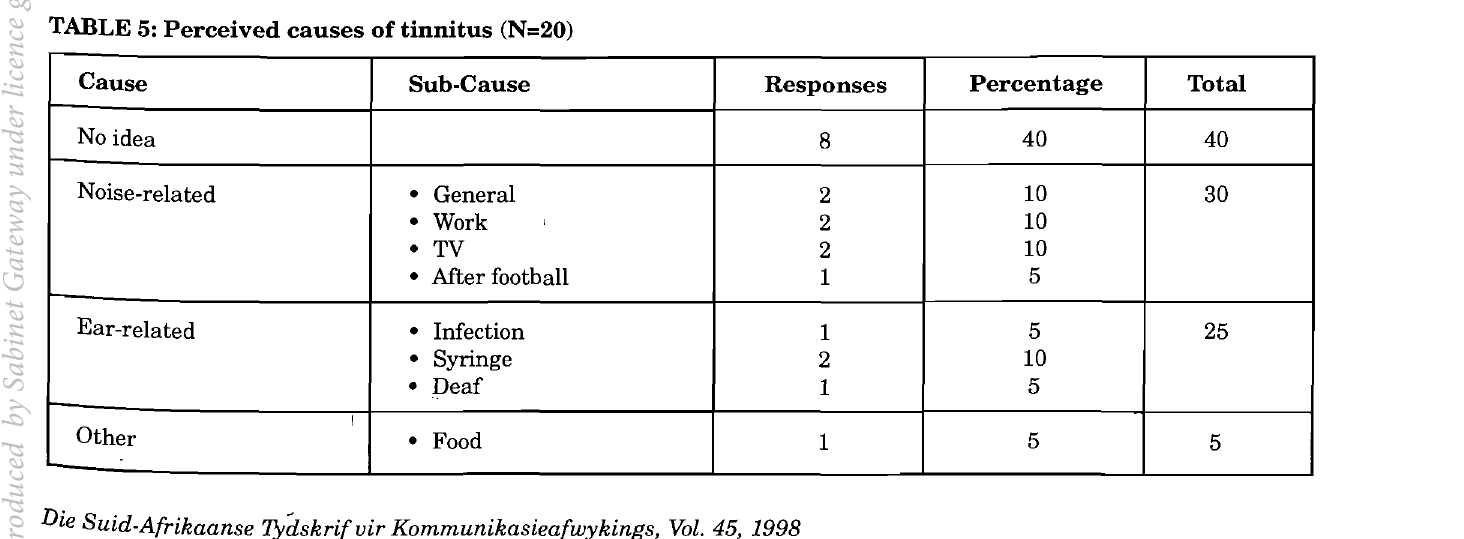
TABLE 5: Perceived causes of tinnitus (N=20)